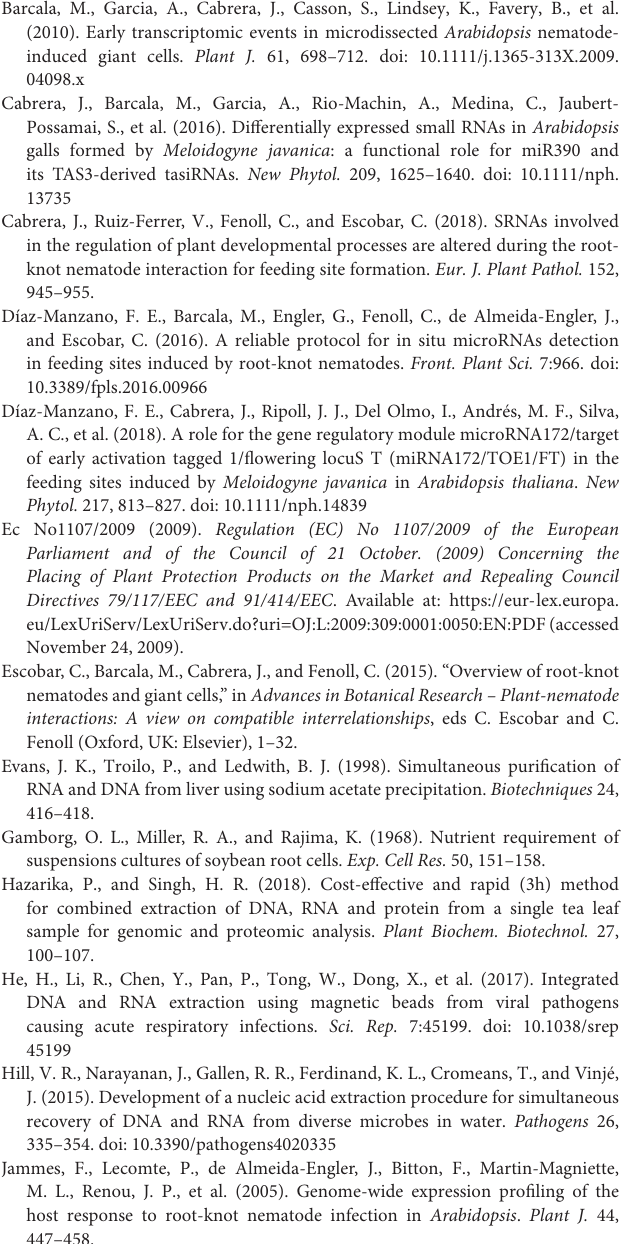
FIGURE S1 | Agarose gel electrophoresis of quantitative-real-time-PCR (qRT- PCR) products of the CHROMOMETHYLASE 2 gene ( CMT2 ). qRT-PCR products of CMT2 (AT4G19020) and GAPC2 ( GLYCERALDEHYDE-3-PHOSPHATE